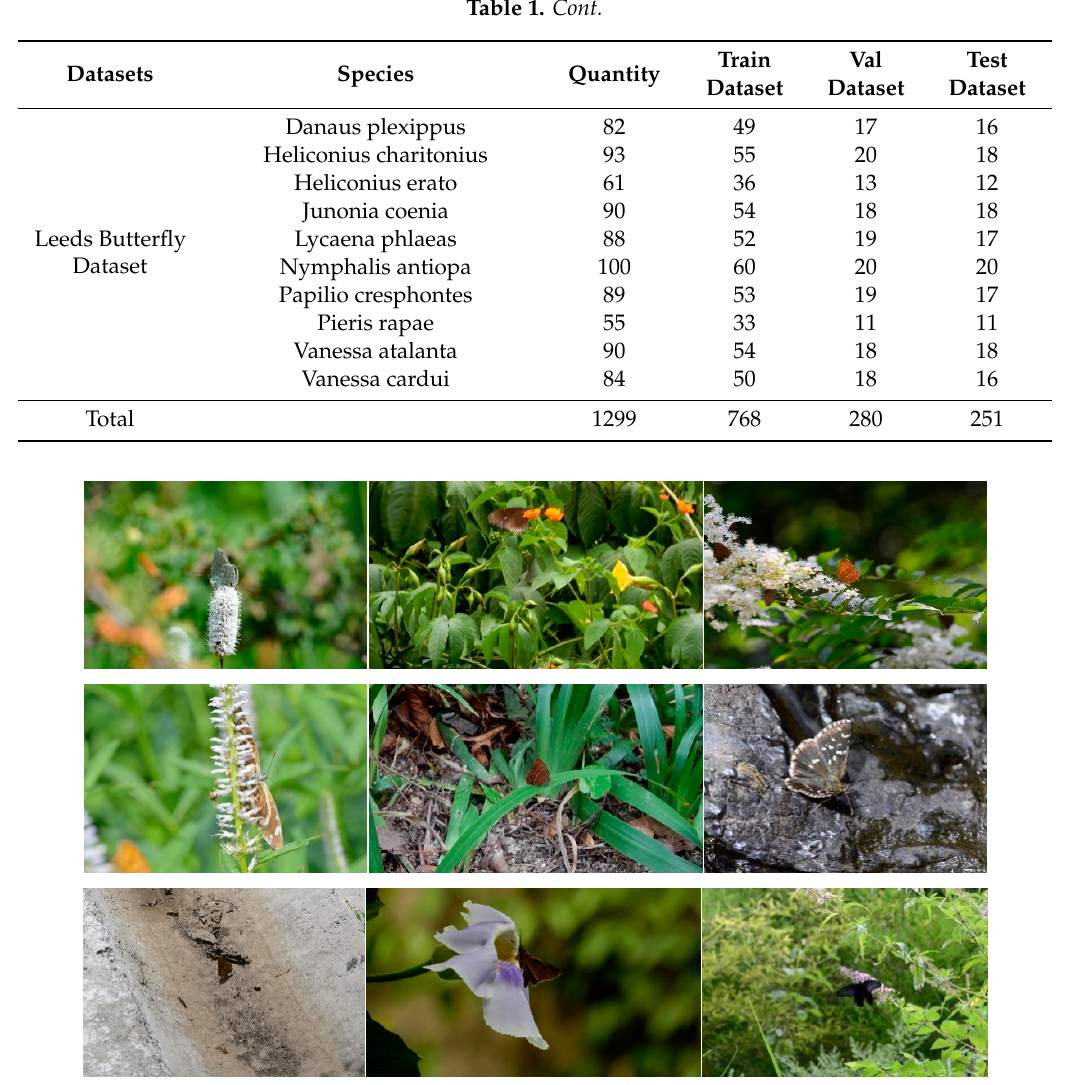
Figure 1. Sample images in the Chinese butterfly dataset.